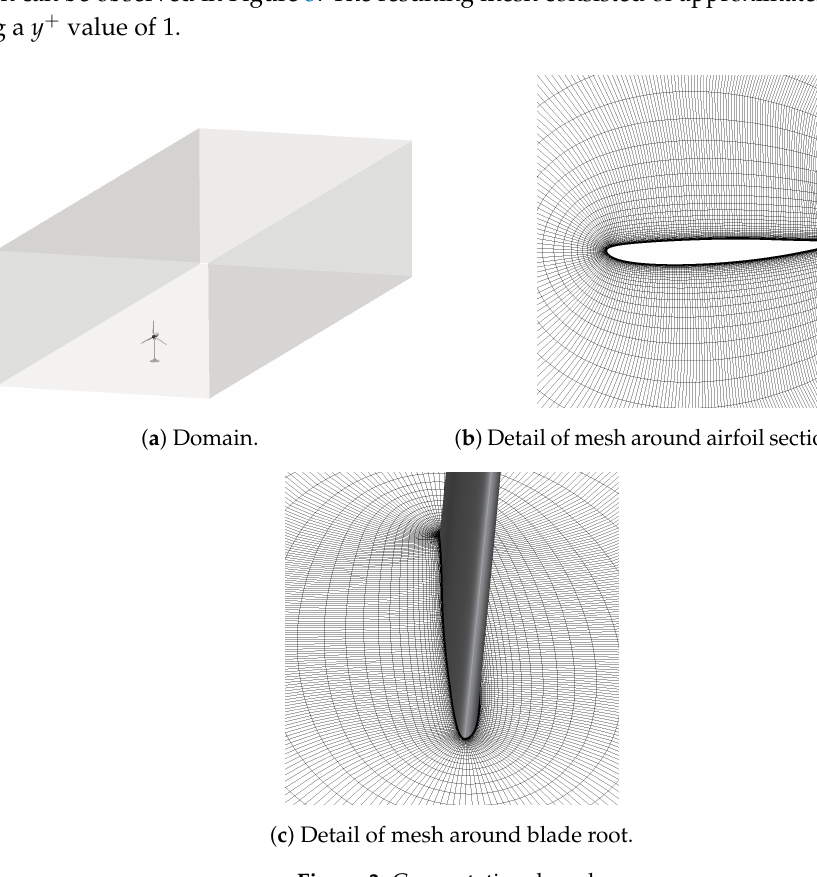
Figure 3. Computational